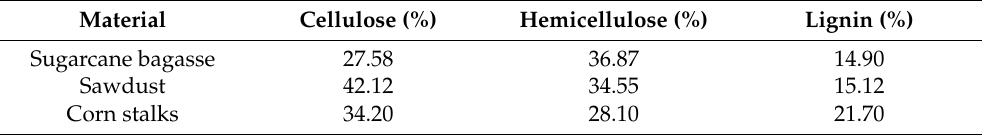
Table 2. Analysis of the lignocellulosic waste used to cultivate Pleurotus eryngii .